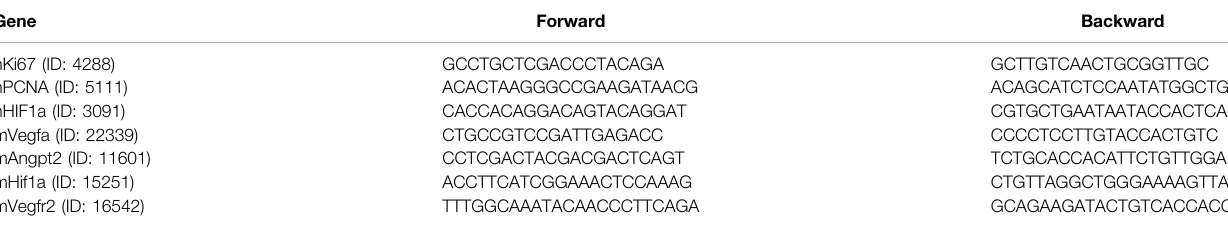
TABLE 1 | Sequences of primers for qPCR